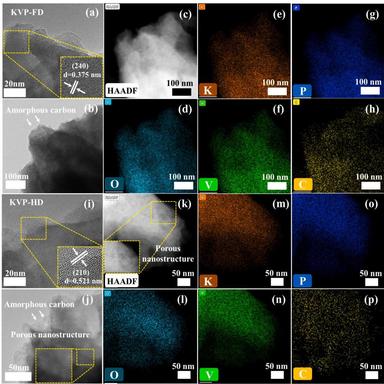
(a-b, i-j) HRTEM images and (c-h, k-p) HRTEM-EDS mapping of KVP-FD and KVP-HD materials, the inset images in Fig. 5a, i, j and k are the magnified images in the selected area.